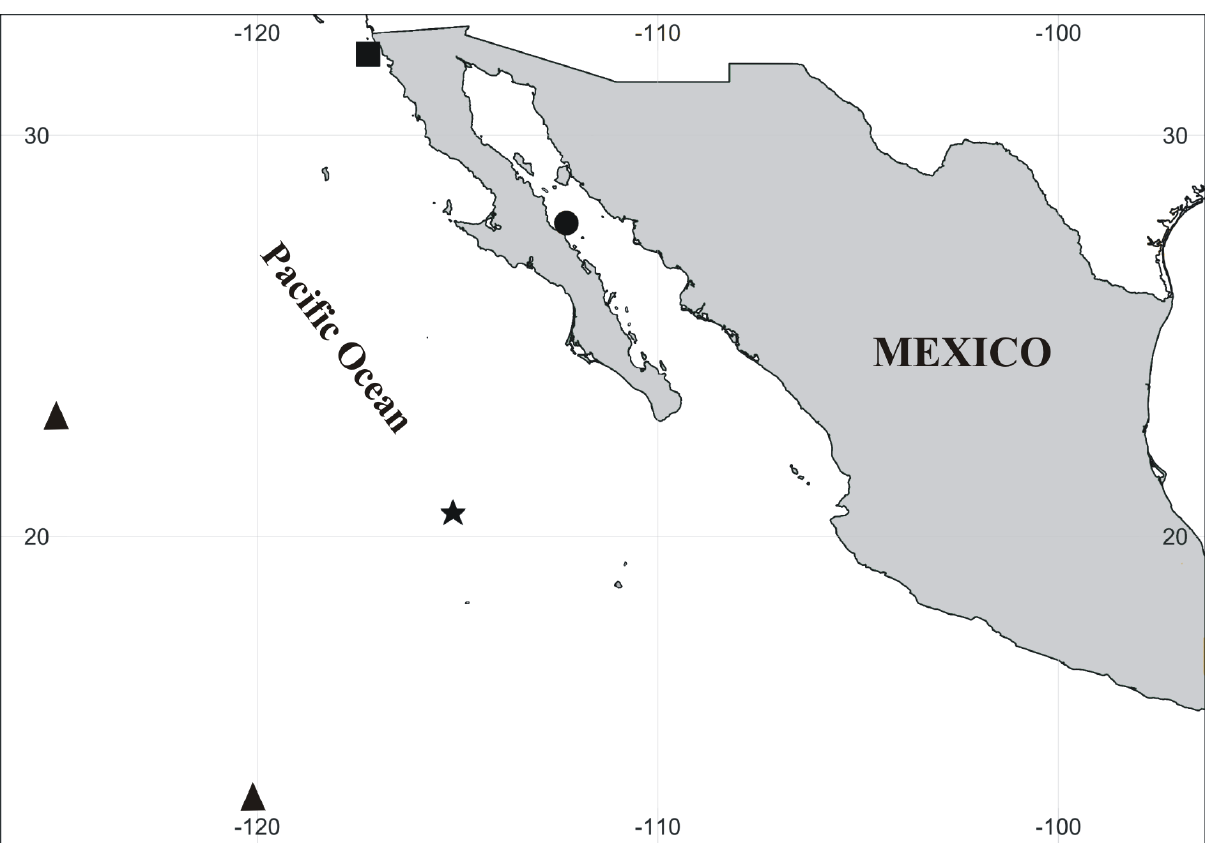
Figure 1. Localities off western Mexico where Petalidium suspiriosum Burkenroad, 1937 was captured. (  ) Burkenroad, 1937; ( ▲ ) Hanamura, 1983; ( ■ ) USNM 170359; ( ● ) present